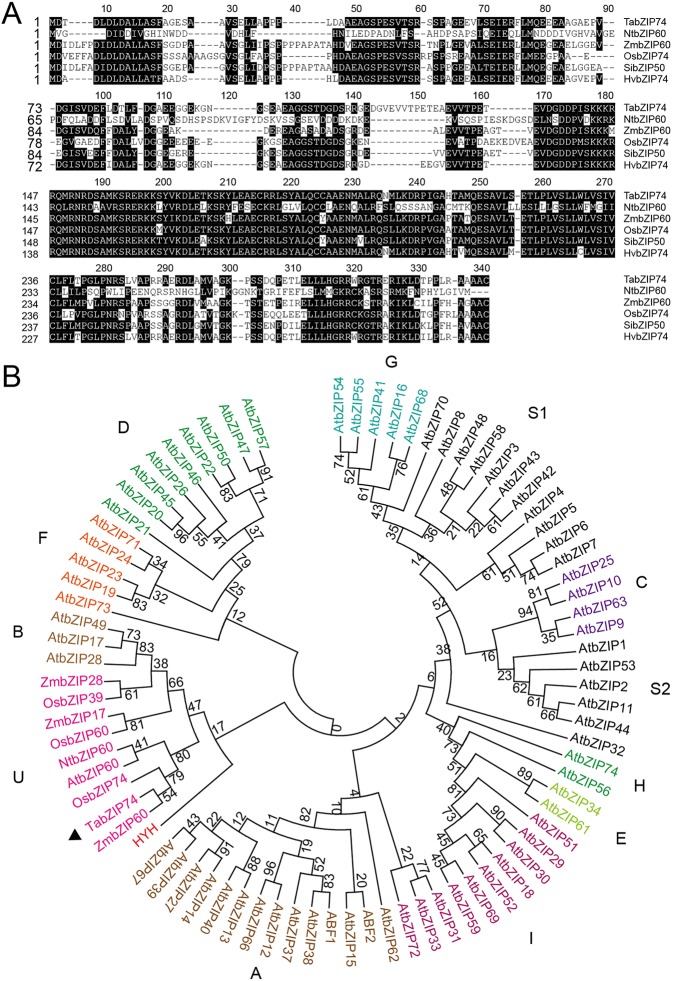
Phylogenetic tree of bZIP transcription factors and alignment of amino acid sequences of TabZIP74. (A) Amino acid alignment of TabZIP74 with other bZIP family members of NtbZIP60, OsbZIP74, ZmbZIP60, HvbZIP74, and SibZIP50 from tobacco (Nicotiana tabacum, NP_001311663.1), rice (Oryza sativa, XP_015641141.1), maize (Zea mays, NP_001147256.1), barley (Hordeum vulgare, BAJ96708.1), and millet (Setaria italica, XP_004965858.1), respectively. The numbers on the left indicate amino acid positions. Identical amino acid residues are shaded black, representing >50% similarity of conserved amino acids. (B) Phylogenetic tree of TabZIP74 with selected bZIP TFs from rice (OsbZIPs), Arabidopsis (AtbZIPs), tobacco (NtbZIPs), and maize (ZmbZIPs). Genbank accession numbers of the factors are listed in
Supplementary Table 1
. The subgroups were designated as A, B, C, D, E, F, G, H, S1, S2, and U, according to the analysis results (Jakoby et al., 2002; Zhou et al., 2017).